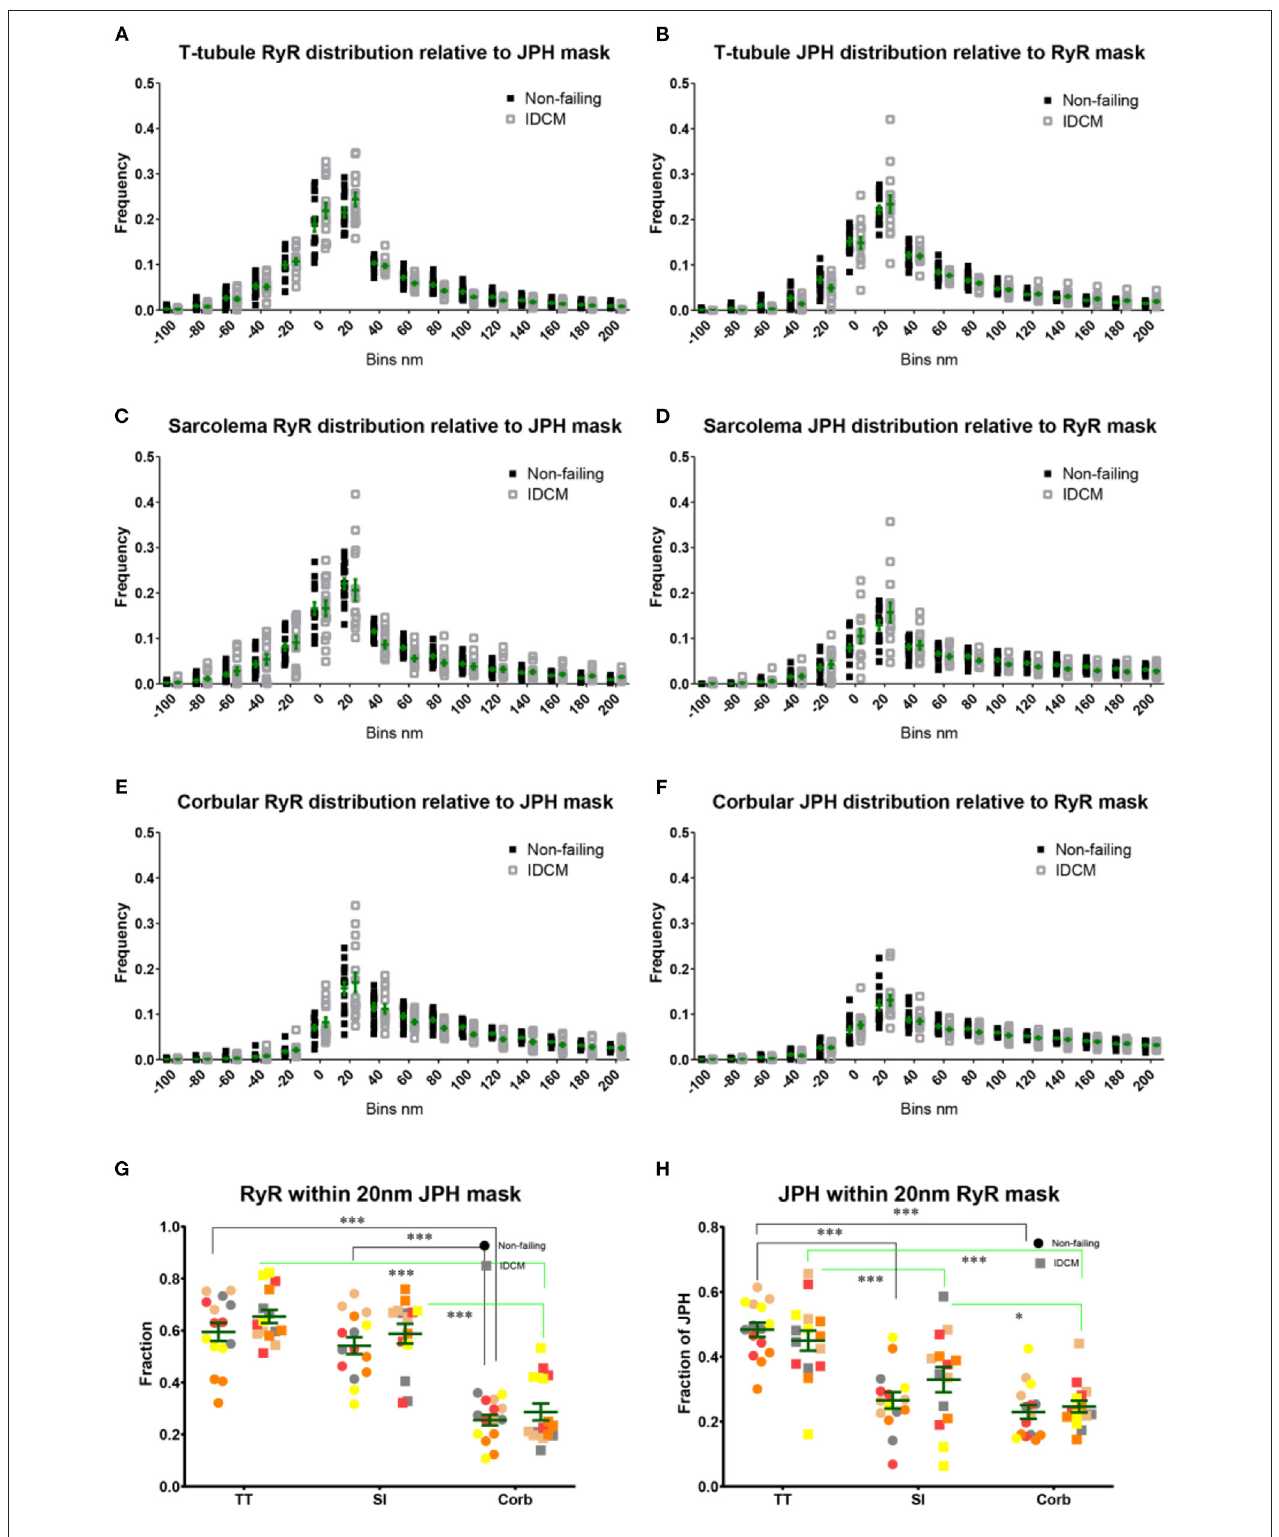
FIGURE 2 | Nanoscale distribution of RyR and JPH labelling in donor and IDCM human cardiac myocytes at t-tubular, sarcolemmal and corbular regions. (A) Frequency plot of RyR distribution relative to the mask of JPH labelling at the T-tubule regions. (B) Frequency plot of JPH distribution relative to the mask of RyR labelling at the T-tubule regions. (C) Frequency plot of RyR distribution relative to the mask of JPH labelling at the sarcolemmal regions. (D) Frequency plot of JPH